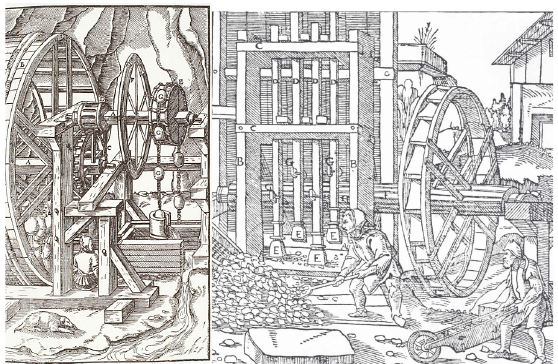
Figure 7.A mine pump (left) and the cam principle applied in a rock-crushing mill (right) as illustrated by Georgius Agricola’s De Re Metallica (1556) [24-25].